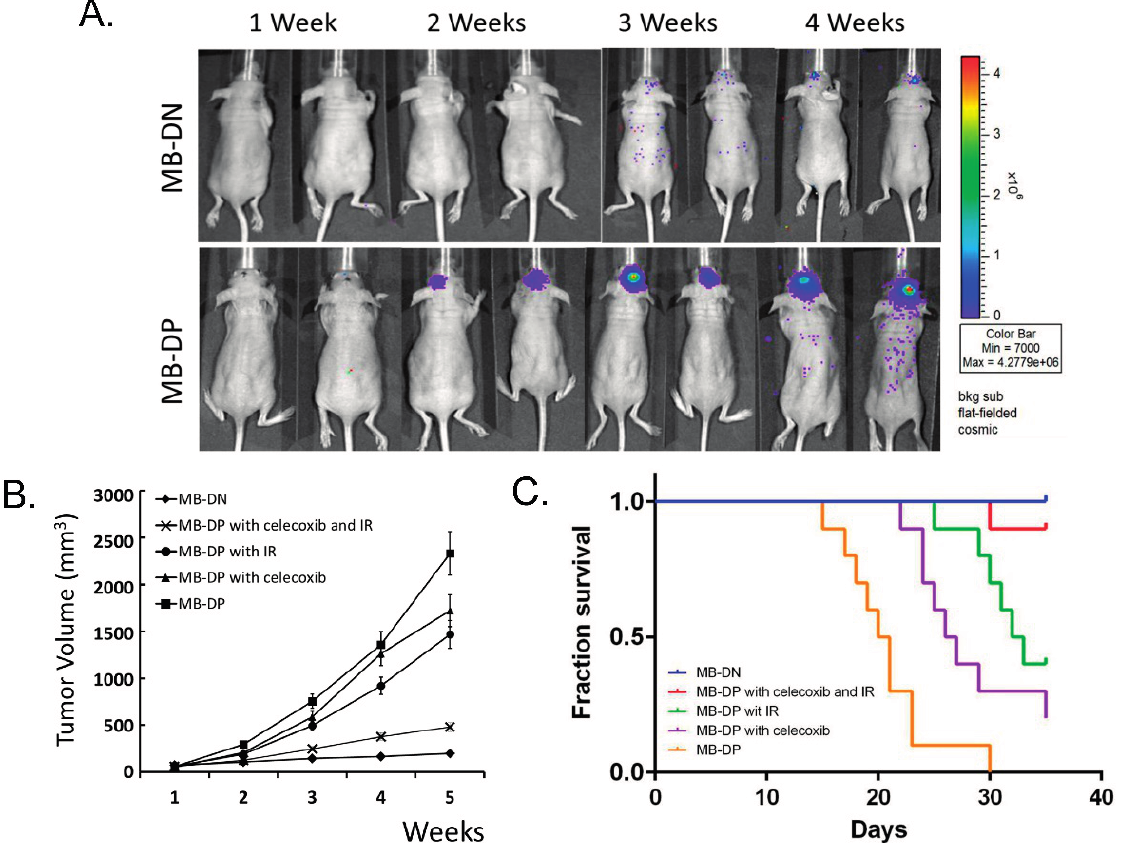
Figure 6. Celecoxib and irradiation may enhance the inhibition on MB tumorigenesis and recipient survival in orthotopic MB-DP-transplanted immunocompromised mice. ( A ) Representative bioluminescence images (BLI) of immunocompromised mice transplanted with MB-DP cells or MB-DN cells with firefly luciferase labeling at the indicated time points after cell inoculation; ( B ) Quantification of tumor volume in recipients of MB-DN cells or MB-DP cells treated with celecoxib, IR, or the combination of celecoxib and IR; and ( C ) The cumulative survival of MB-DP cells-xenotransplanted recipients receiving celecoxib, IR or the combination of celecoxib and IR. p < 0.05 vs.